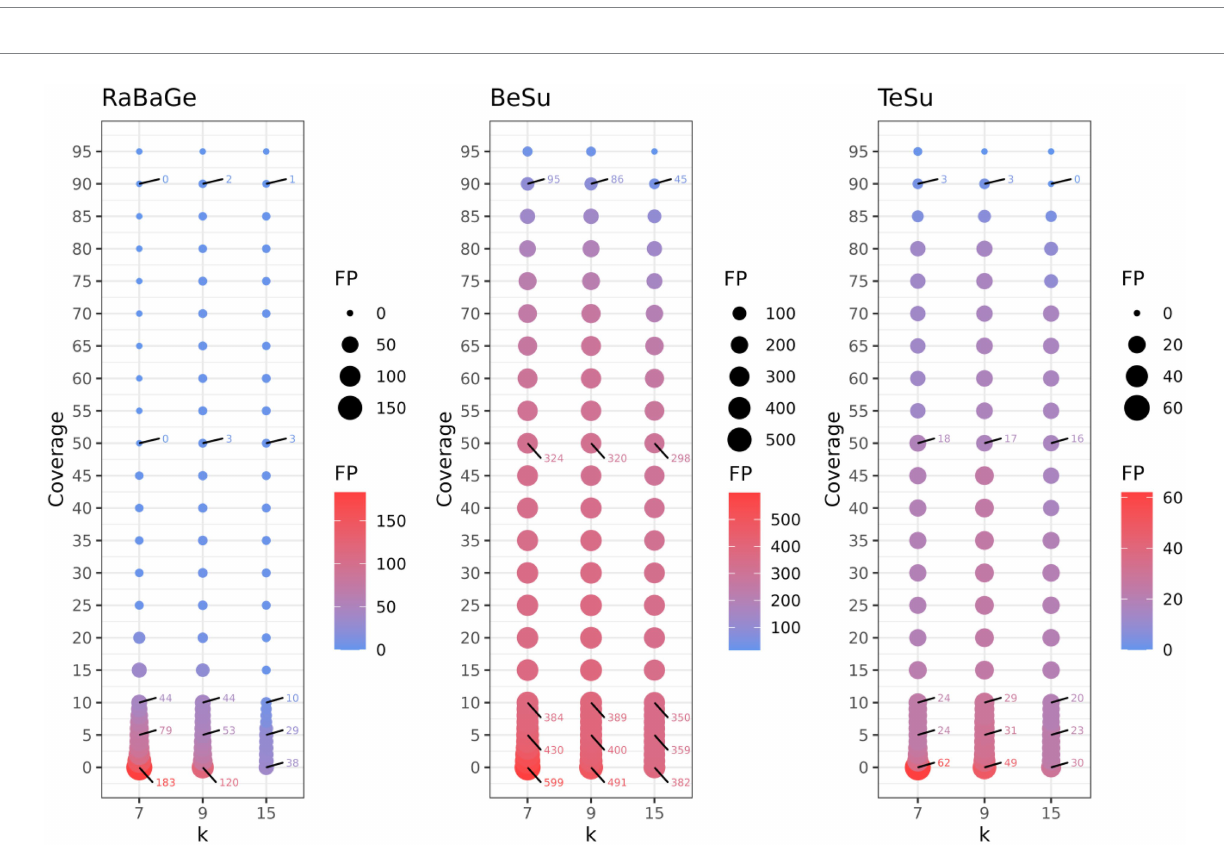
FIGURE 3 Assessment of KARGVA’s false positive rate on semi-synthetic data by varying k -mer length and gene coverage threshold. The X -axis represents the k value (in amino acids, e.g., k = 9 means 27 nucleotides), the Y -axis represents the gene coverage portion (%), and the bubble size represent the false positive counts. RaBaGe, BeSu, and TeSu are synthetic datasets assembled by random bacterial genes (RaBaGe), and PATRIC genome fragments exhibit ingmedium-high similarity to MEGARes betalactamase (BeSu) or tetracycline (TeSu)